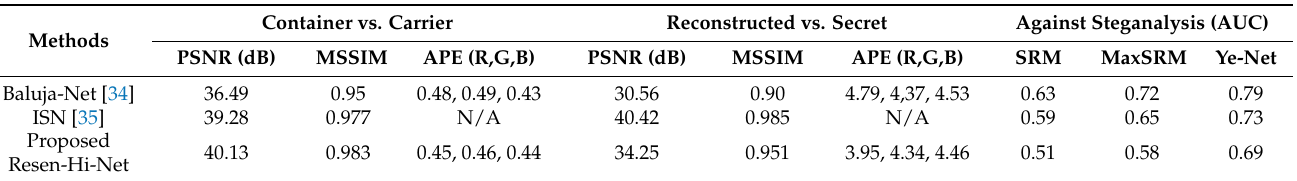
Table 5. Comparative experimental results of the proposed, Baluja-Net [34] and ISN [35] hiding